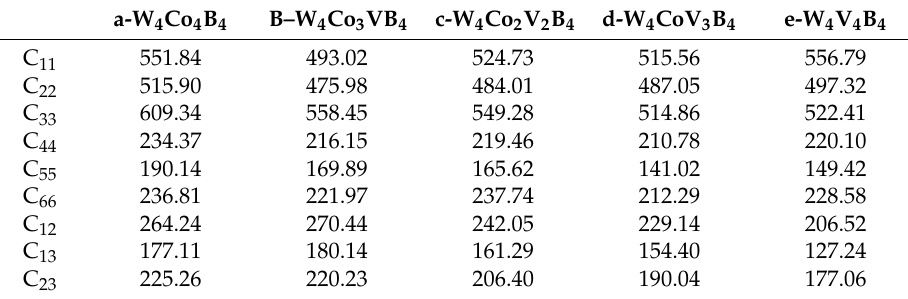
Table 2. The calculated elastic constants (in GPa) of W 4 Co 4 − x V x B 4.